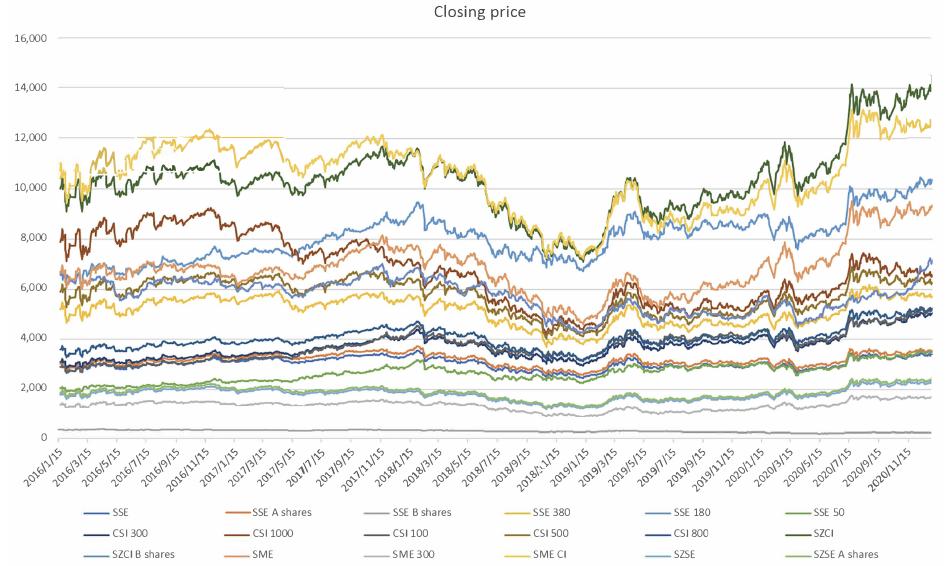
Figure A2. History of closing price in 18 Chinese stock index.